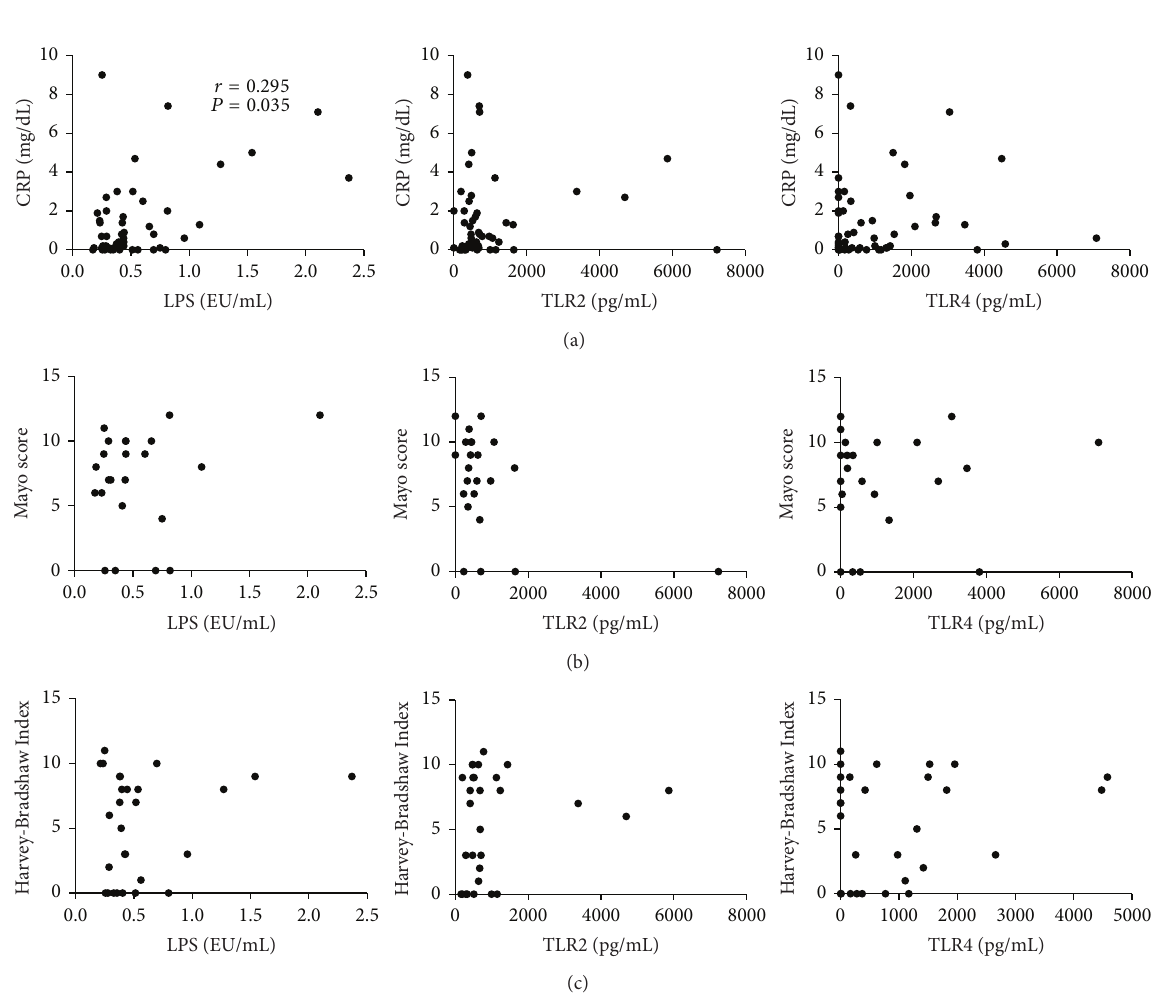
Figure 3: Circulating LPS correlates with biochemical but not clinical activity in IBD patients. Concentrations of LPS, TLR2, TLR4, and CRP were measured in the sera of IBD (both UC and CD) patients. Clinical activity of UC and CD was evaluated using Mayo score and Harvey-Bradshaw Index. (a) Correlation between CRP serum levels and circulating LPS, TLR2, and TLR4 in IBD patients. (b) Correlation between Mayo score and circulating LPS, TLR2, and TLR4 in UC patients. (c) Correlation between Harvey-Bradshaw Index and circulating LPS, TLR2, and TLR4 in CD patients. Statistical analysis was performed by means of Spearman Correlation Test. 𝑃 < 0.05 was considered statistically